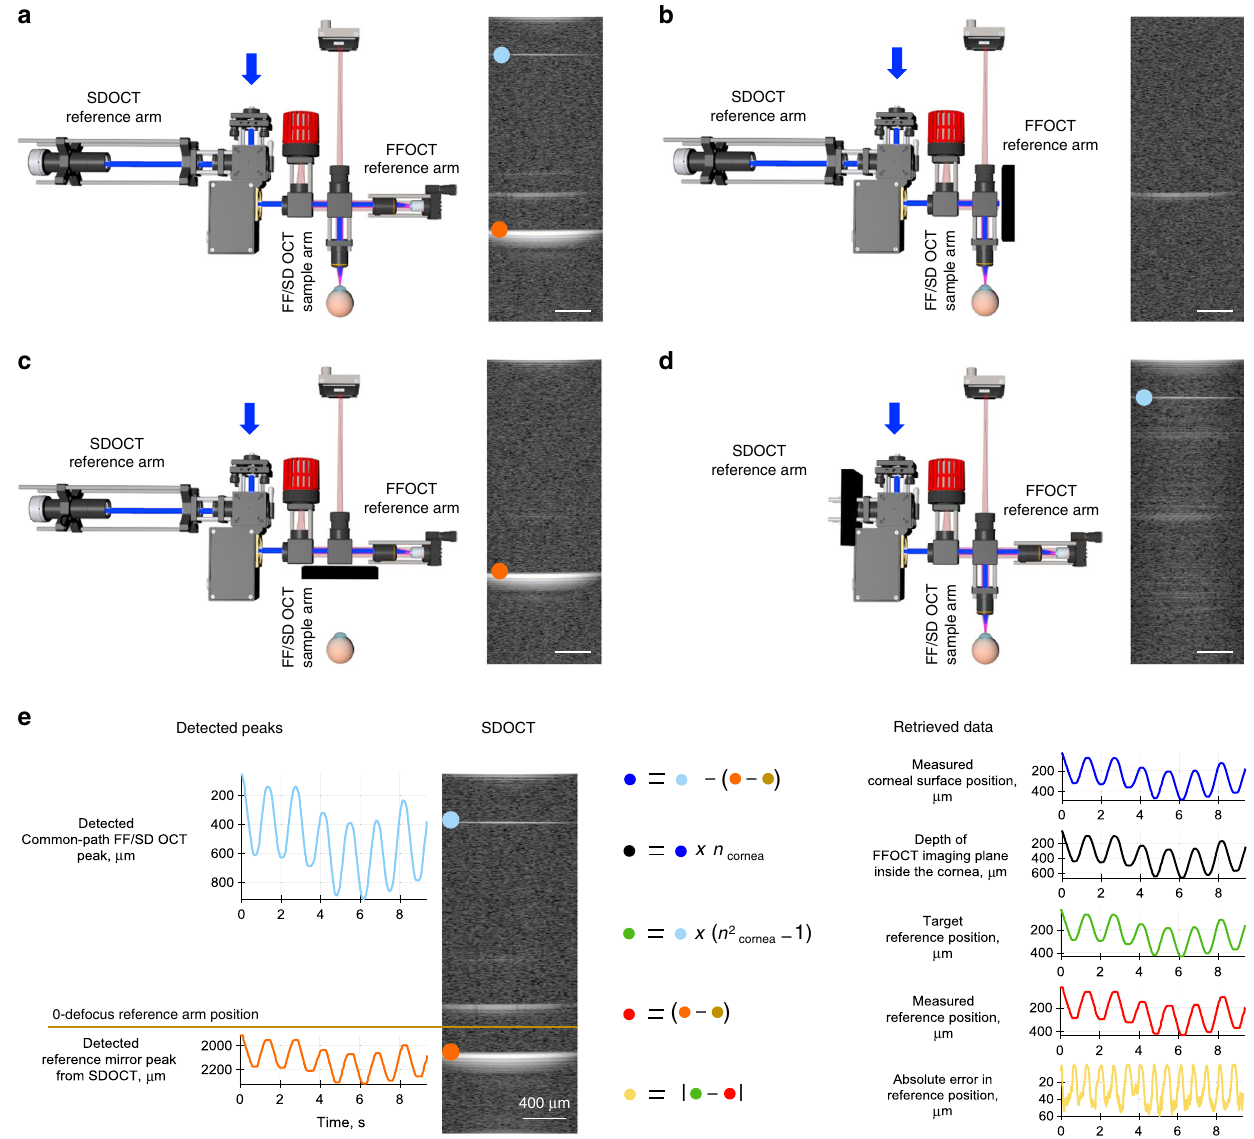
Fig. 2 Real-time detection of back-scattering intensity in SDOCT and calculation of corneal and reference mirror locations. a Left, common-path FF/SD OCT interferometer with light passing through all optical arms. a Right, SDOCT image with three planes of backscattered/re fl ected light. b Left, the same device with blocked FFOCT reference arm. Right, SDOCT image with a single re fl ected peak, corresponding to the surface of the cornea. c Left, device with blocked sample arm. Right, SDOCT image with re fl ection from the FFOCT reference mirror (orange dot). d Left, device with blocked SDOCT reference arm. Right, SDOCT image shows on top a single sharp re fl ection, originating from the FFOCT interference and captured by SDOCT (common-path peak, light- blue dot). Its narrowness re fl ects the perfect dispersion matching in identical arms of the FFOCT interferometer. e Left, SDOCT image with common-path and reference mirror peaks being detected in real-time (Supplementary Movie 3). Both of these maxima move down when the reference arm is extended for defocus correction. This facilitates their detection, as we can separate only the common-path peak for the upper area of the SDOCT image and the reference arm peak for the lower part without their overlapping. Right, using current locations of the two maxima and initial location of the reference mirror, one can calculate the corneal surface position in real-time, along with the depth of the FFOCT imaging plane in the cornea, the optimal reference position for the current corneal location, the actual reference position and the error between the two, used for validating and improving the optical arms matching loop. All scale bars are 400 µ m. The source data underlying plots in e are provided as a Source Data fi